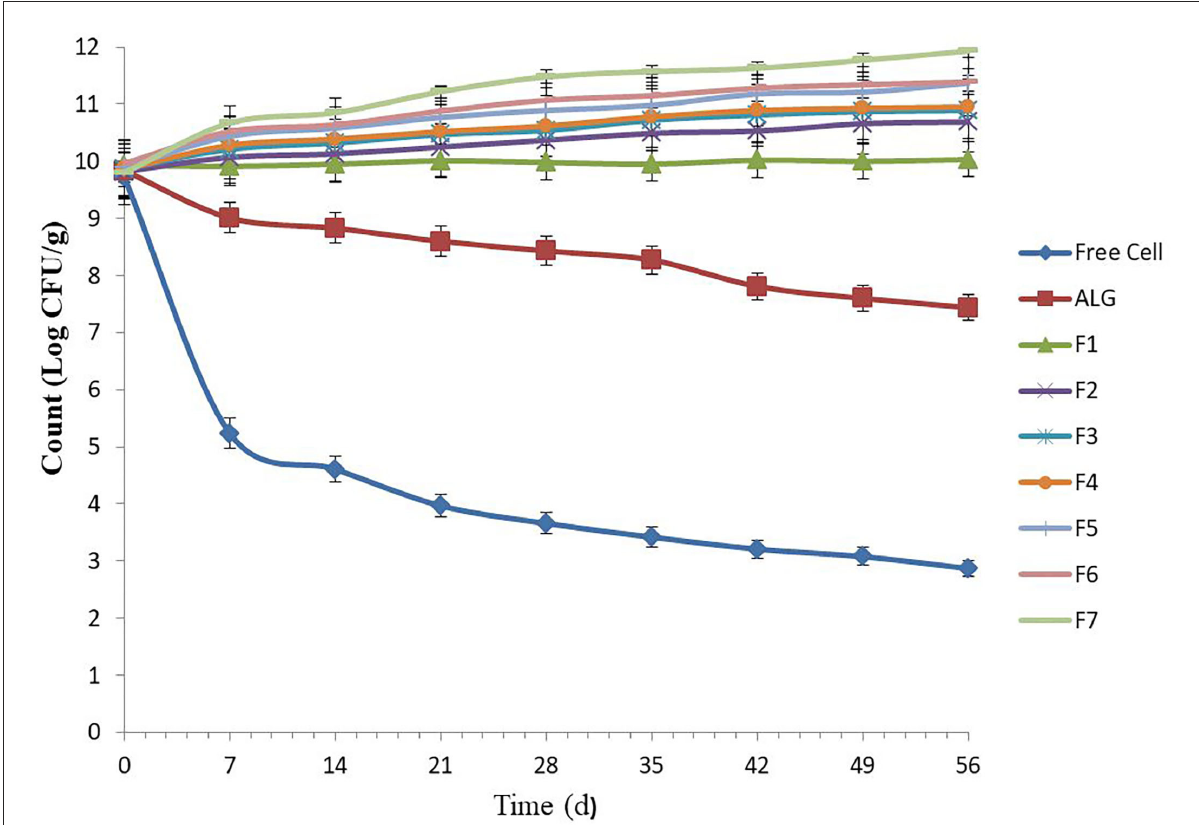
FIGURE1 Number of free and microencapsulated E. faecium with different gel and prebiotic formulations during 8 weeks storage in food pellet at 25 ◦ C. Alginate-encapsulated cells [0.8% (w/v)] were used as control. F1: ALG (0.6%) + PG (0.2%); F2: ALG (0.6%) + PG (0.2%) + FOS (0.2%); F3: ALG (0.6%) + PG (0.2%) + FOS (0.3%); F4: ALG (0.6%) + PG (0.2%) + FOS (0.4%); F5: ALG (0.6%) + PG (0.2%) + Fk (0.2%); F6: ALG (0.6%) + PG (0.2%) + Fk (0.3%); F7: ALG (0.6%) + PG (0.2%) + Fk (0.4%). Values shown are means ± standard deviations ( n =